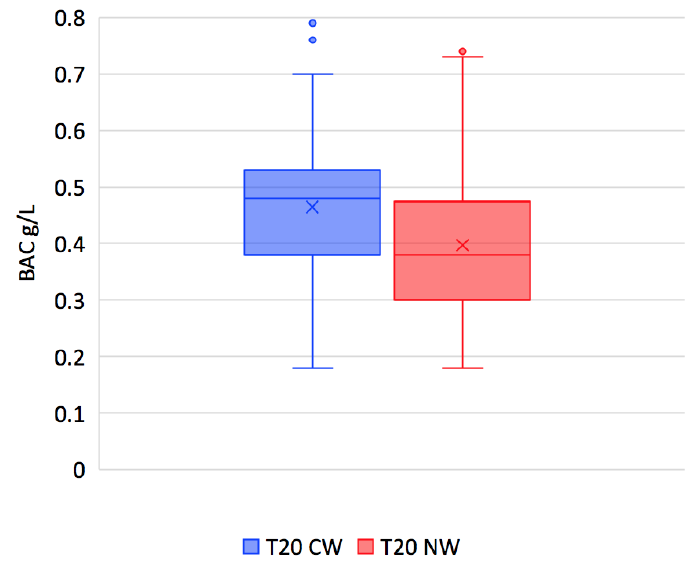
Figure 3. Box-and-whisker diagram of the blood alcohol concentration (BAC) levels at T20 after the ingestion of the conventional wine (CW) and of the natural wine (NW) (g/L) ( p <